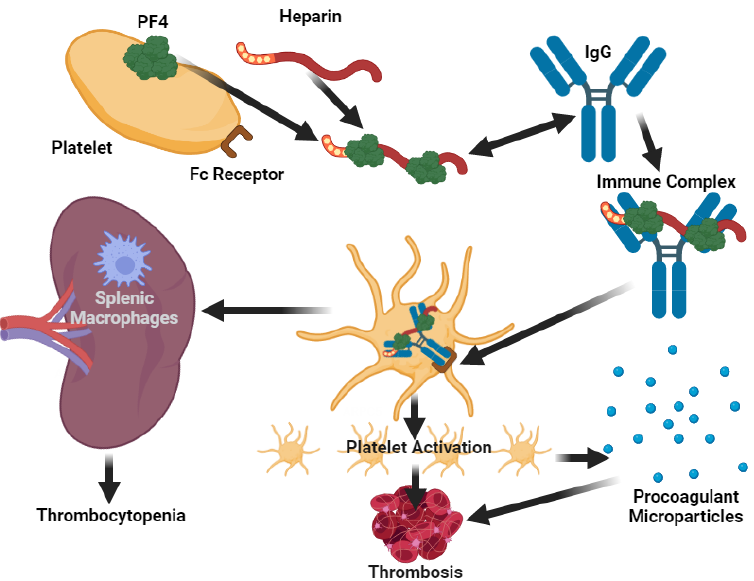
Figure 3. Pathophysiological mechanism of heparin-induced thrombocytopenia (HIT). Platelet factor 4 (PF4) is a chemokine secreted from the alpha-granules of platelets, released as tetramers. They bind to heparin and other proteoglycans and inactivate them. The binding of heparin to PF4 exposes new antigen sites and hence the formation of new (IgG) antibodies. Platelet Fc receptors bind the antibody-heparin-PF4, which contribute to thrombosis. Thrombocytopenia occurs by two mechanisms: removal of platelets with bound IgG by splenic macrophages and platelet consumption caused by thrombus formation. PF4 can also bind heparin sulfate on vascular endothelial cells; subsequent binding of the pathologic antibody to this PF4-heparin sulfate complex can injure the endothelium, which further promotes thrombosis. This figure was created using the website https://app.biorender.com (access on 12 July 2021).